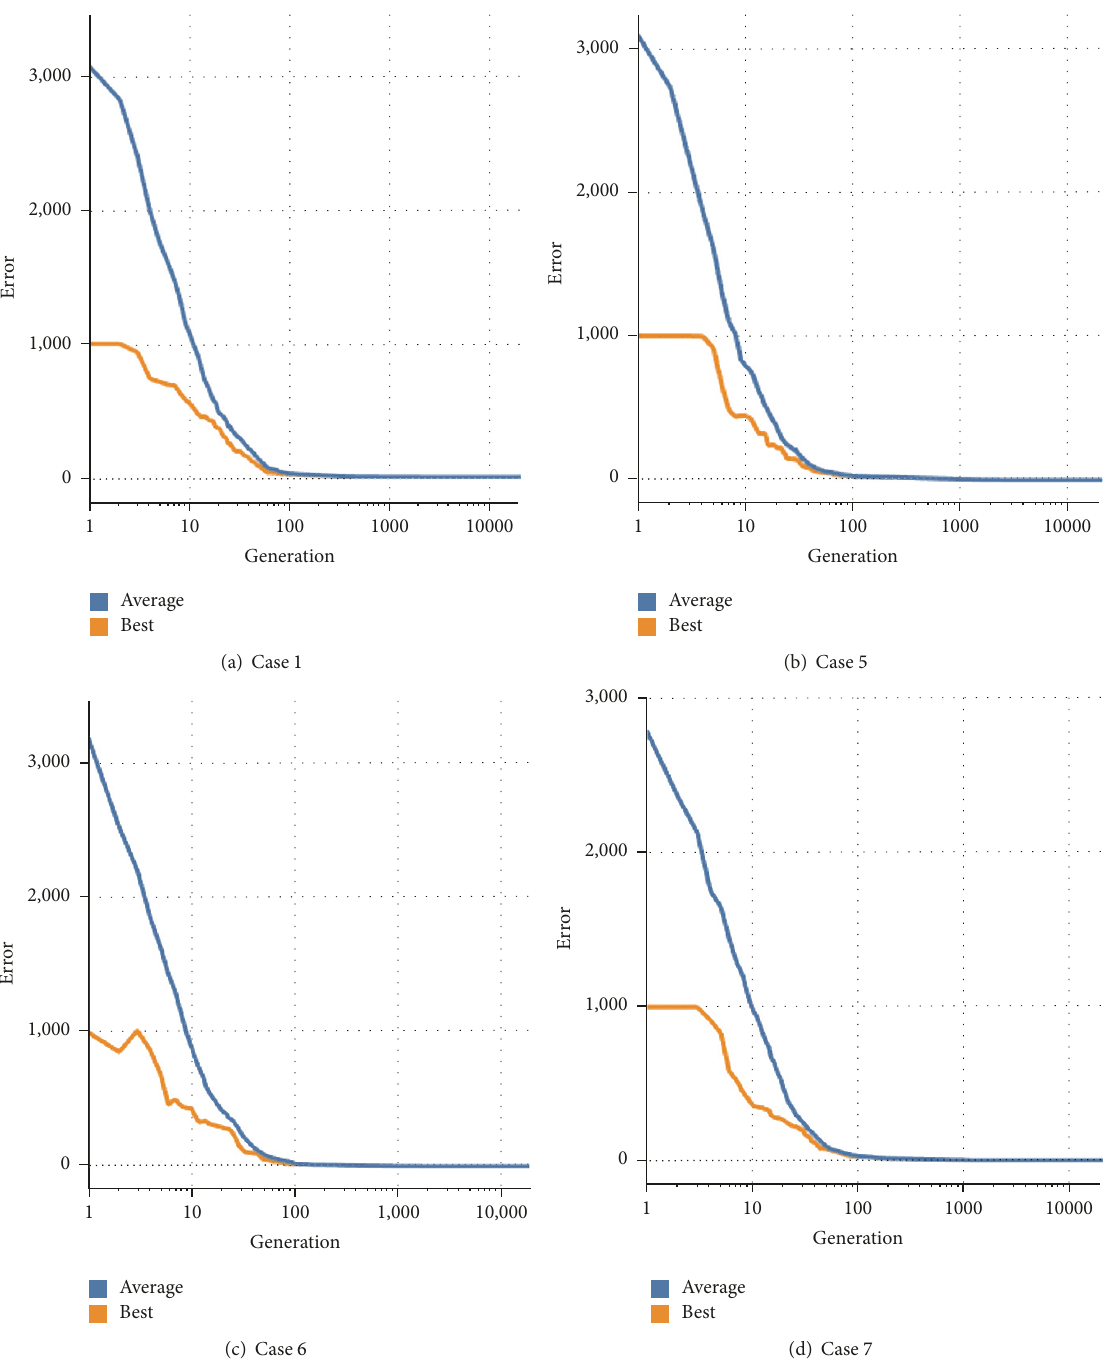
Figure 8: Line graph of showing prediction errors over the number of generations in PSO on four test